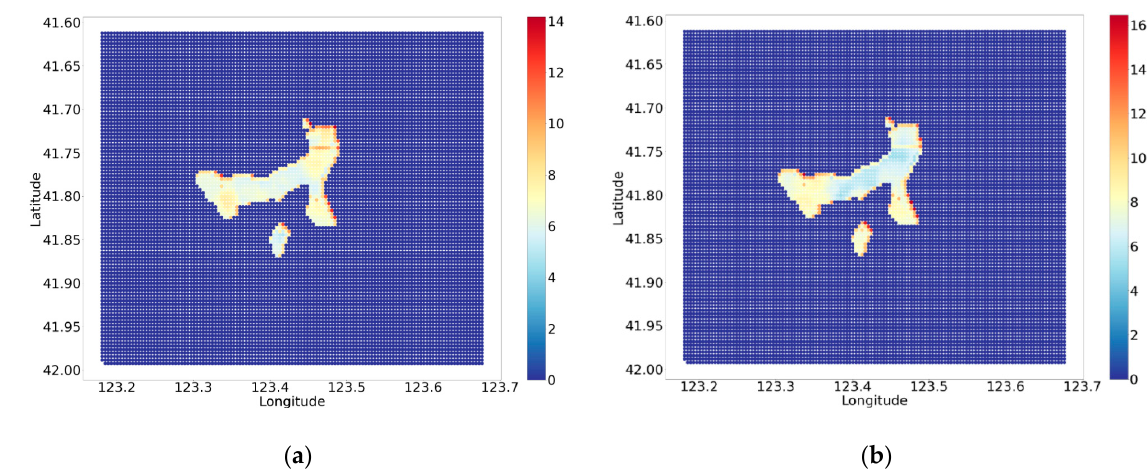
Figure 11. ( a ) The spatial distribution of potential of accident count. ( b ) The spatial distribution of date away from winter.